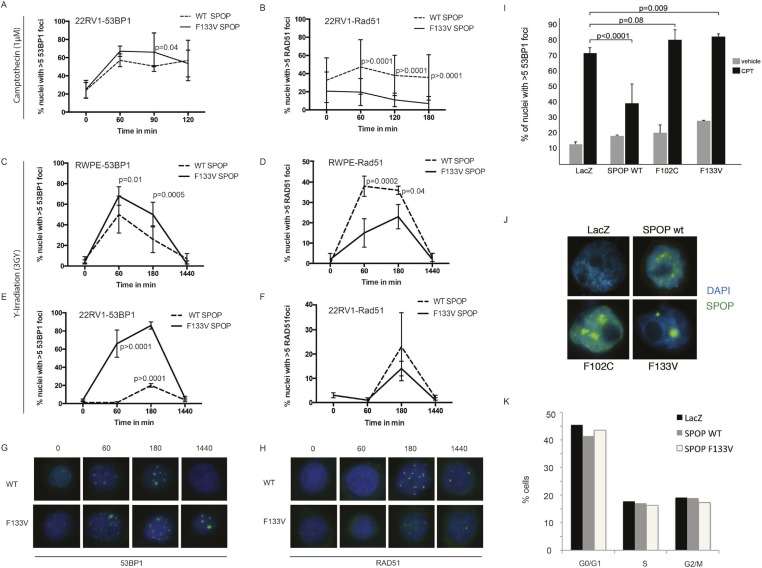
SPOP mutation impairs HDR-DSB repair and promotes NHEJ.(A-F) Quantification of 53BP1 and RAD51 foci in 22RV1 and RWPE cells ectopically expressing SPOP-wt or SPOP-F133V after camptothecin (CPT) (1 μM) or gamma irradiation (3GY)-induced DNA damage. Time indicates the observation interval in minutes including DSB induction (0–60 min) and recovery (60–1440 min). Shown are the percentages of cells for each genotype with more than 5 foci per nucleus. (G, H) Representative pictures of 53BP1 or RAD51 foci (green). Blue represents nuclear DNA stained with DAPI. (I) Quantification of 53BP1 foci in RWPE ectopically expressing SPOP-wt, SPOP-F102C or SPOP-F133V mutant SPOP after CPT (1 μM, 1 hr)-induced DNA damage. (J) Immunofluorescence staining of MYC-tagged SPOP in RWPE cells confirms nuclear localization. Blue indicates DAPI-stained DNA. Green foci indicate SPOP protein. Error bars represent s.e.m. (K) Propidium iodide-based cell cycle analyses of RWPE cells.